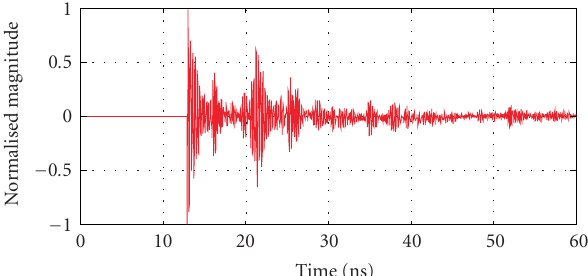
Figure 10: Temporal response of the experiment room in symmet- ric case (cf. Figure 8).